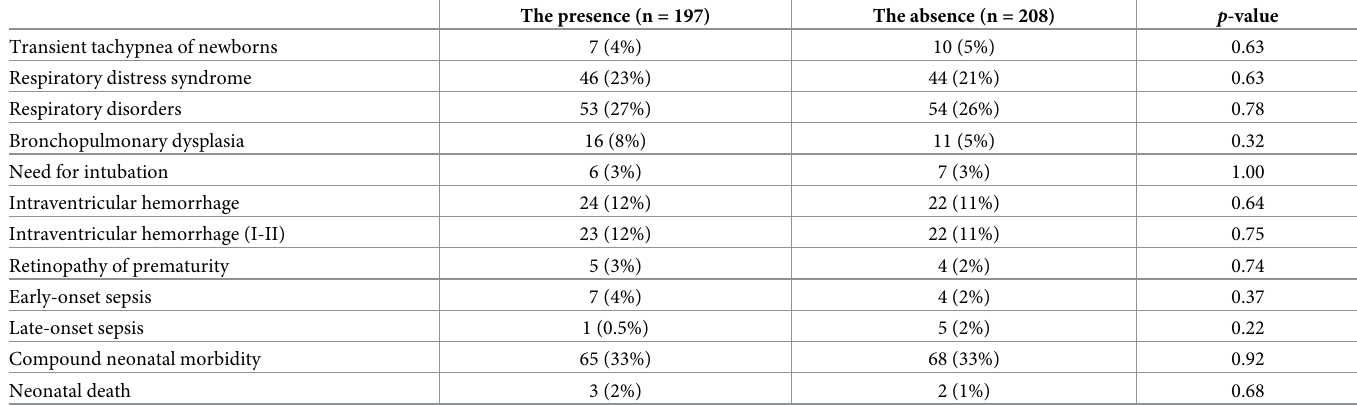
Table 3. Selected aspects of short-term neonatal morbidity with respect to the presence or absence of the abundant cervical Gardnerella vaginalis in women with preterm prelabor rupture of